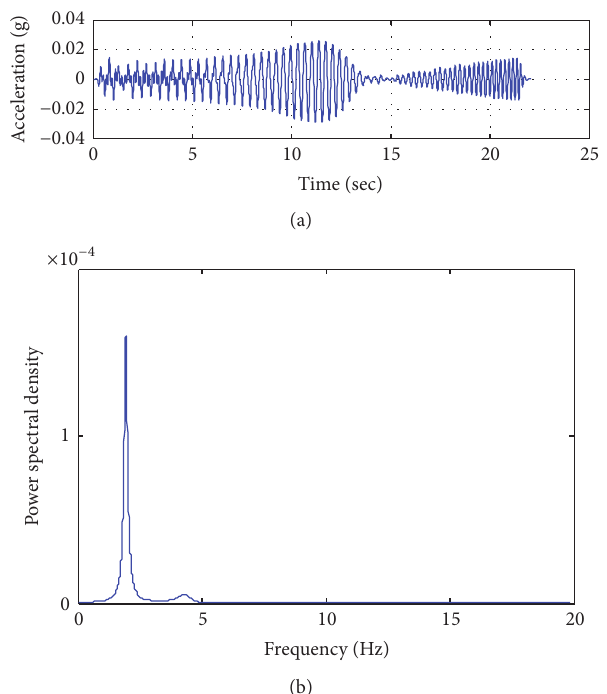
Figure 6: Generated artificial excitation signal: (a) time history domain representation of the signal and (b) frequency domain representation of the signal.